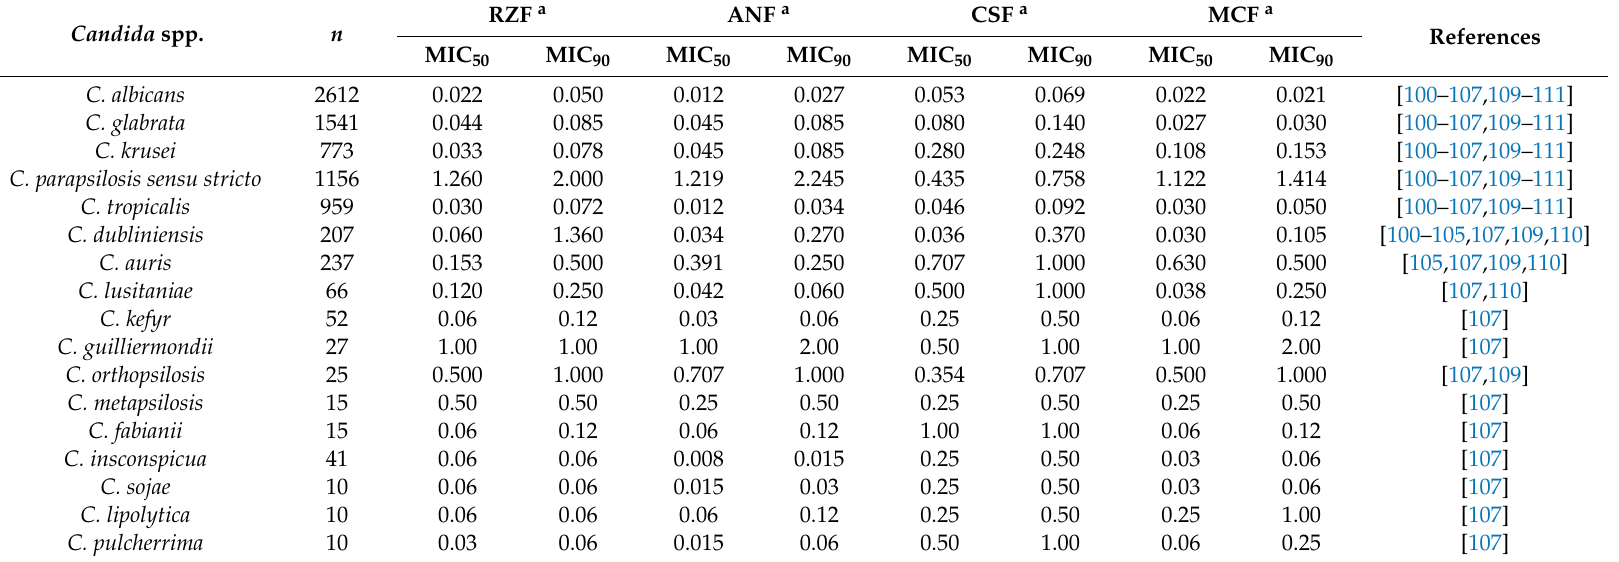
Table 1. Rezafungin and FDA-approved echinocandin MIC values for Candida spp. with wild type FKS genes determined by Clinical and Laboratory Standards Institute (CLSI) and / or European Committee on Antimicrobial Susceptibility Testing (EUCAST) microdilution reference methods. Candida spp.